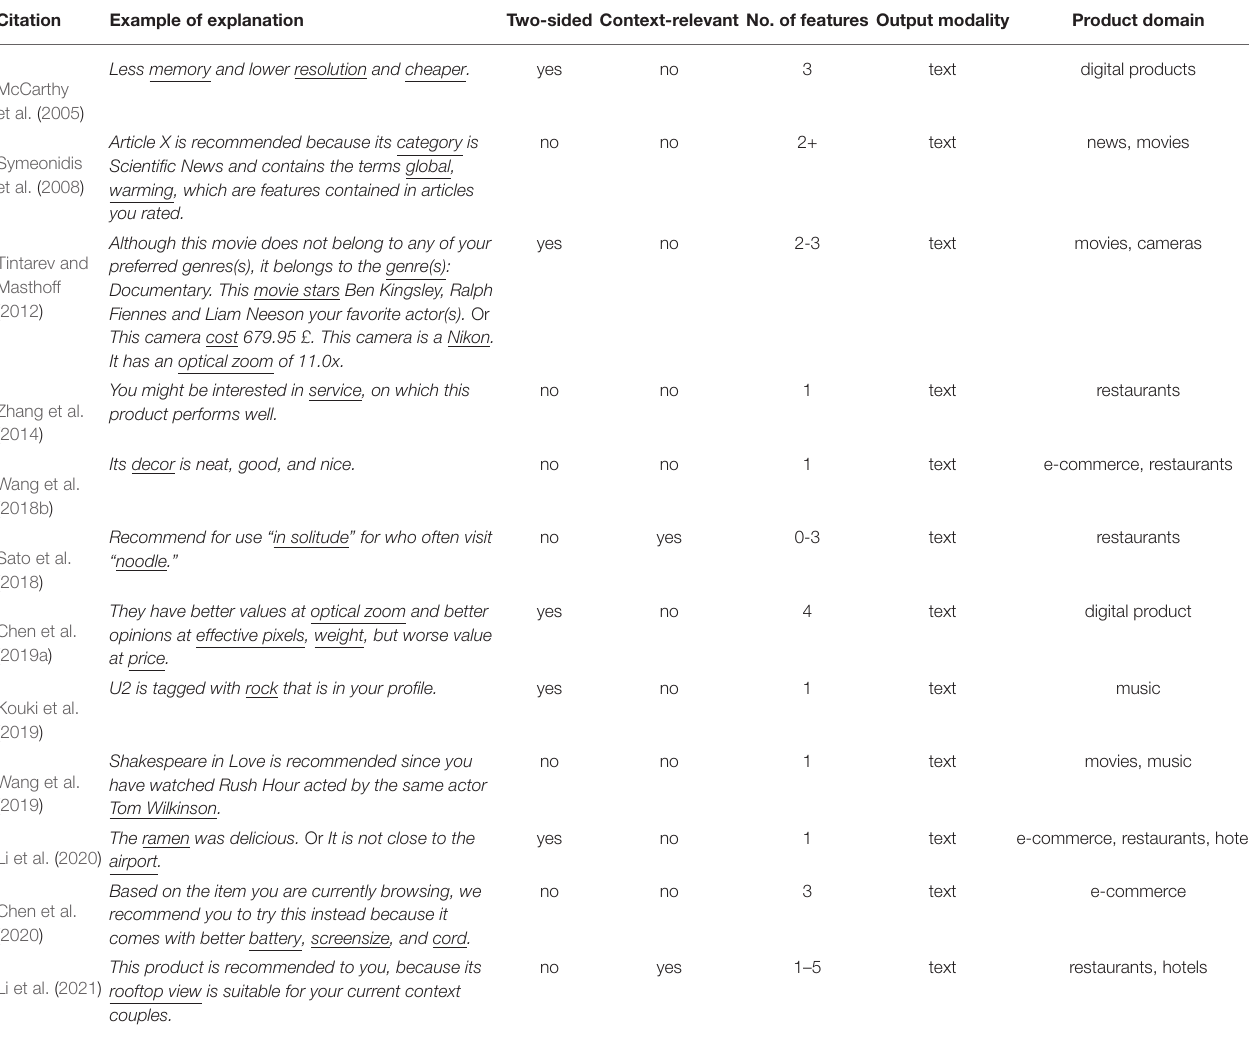
TABLE 1 | Summary of related work on feature-based explanations for